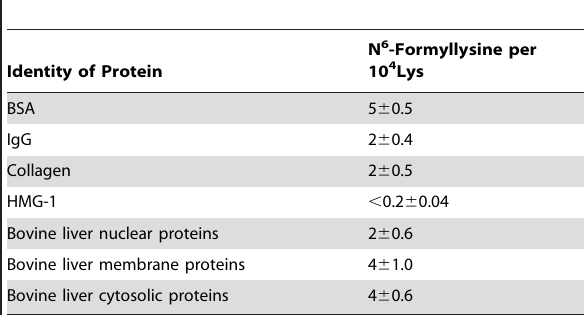
Table 2. Quantification of N 6 -formyllysine in different